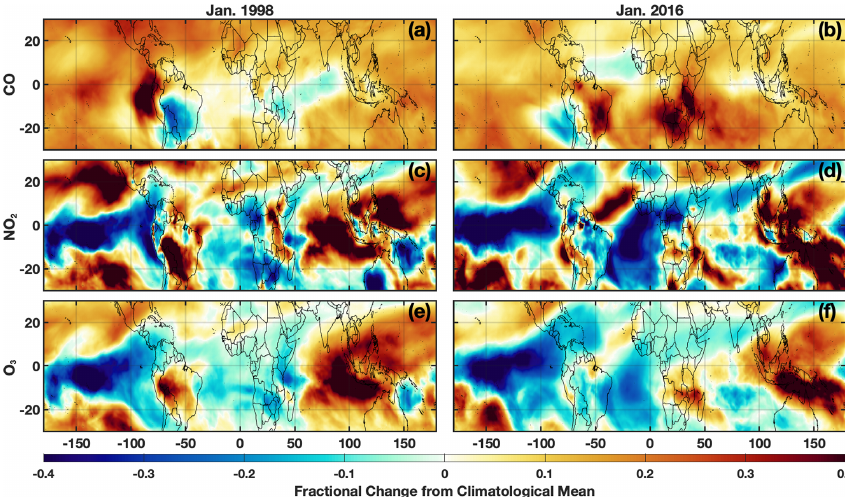
Figure 8. Fractional difference in the indicated variable between January 1998 (a, c, e) and the climatological mean (1980–2019) calculated from the MERRA2 GMI simulation for the MFT. The same values but for January 2016 are indicated on the right. Species shown are CO (a, b) , NO 2 (c, d) , and O 3 (e, f) .